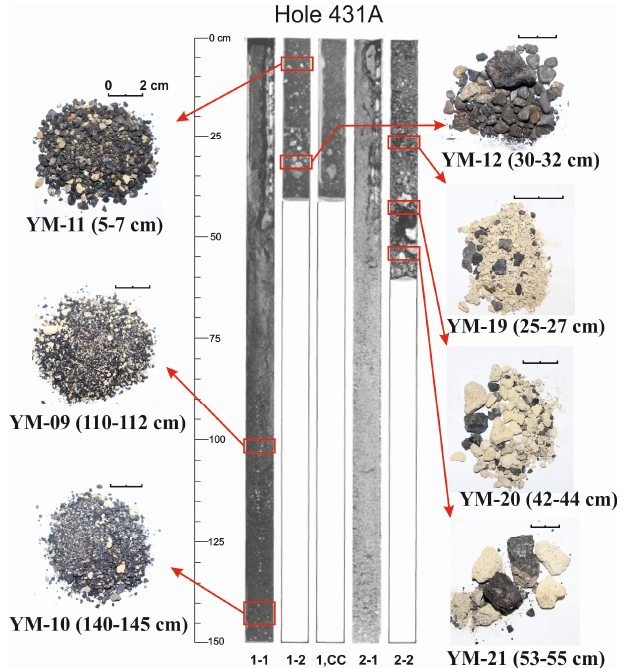
Figure 4. Fragments of Fe-Mn deposits from Hole 431A DSDP and sampling interval location (core photo from [27].